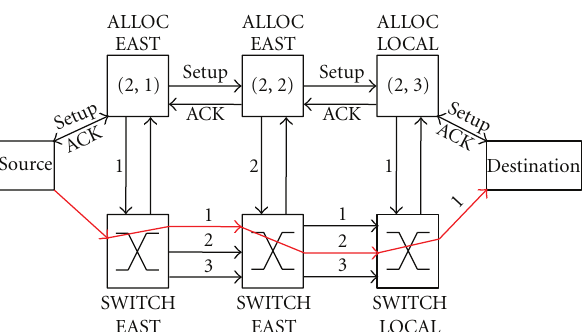
Figure 11: SDM path between source (2,1) and destination